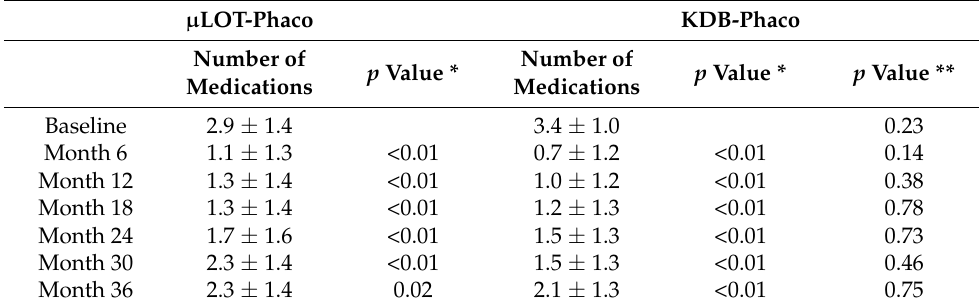
Table 3. Changes in the preoperative and postoperative number of IOP-lowering medications. µ